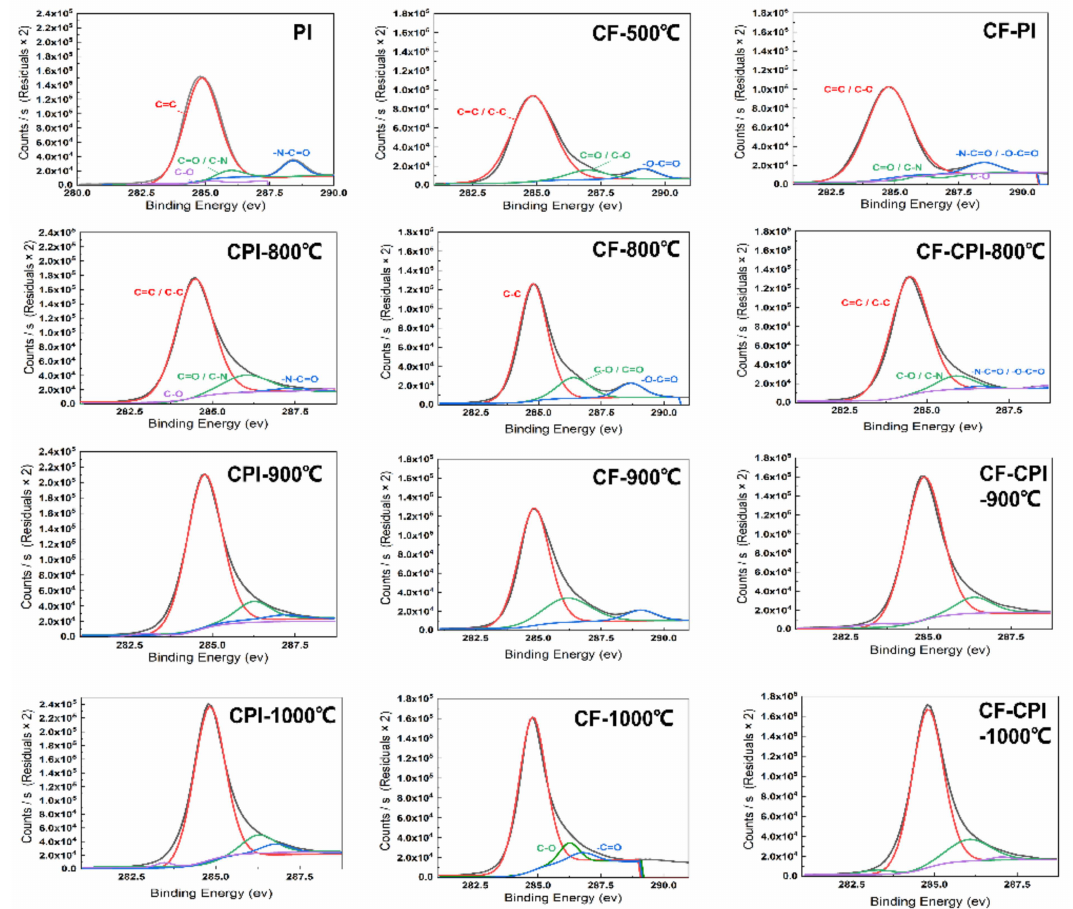
Figure 7. X-ray photoelectron spectroscopy images of polyimide aerogels, pre-carbonized foams and composites.